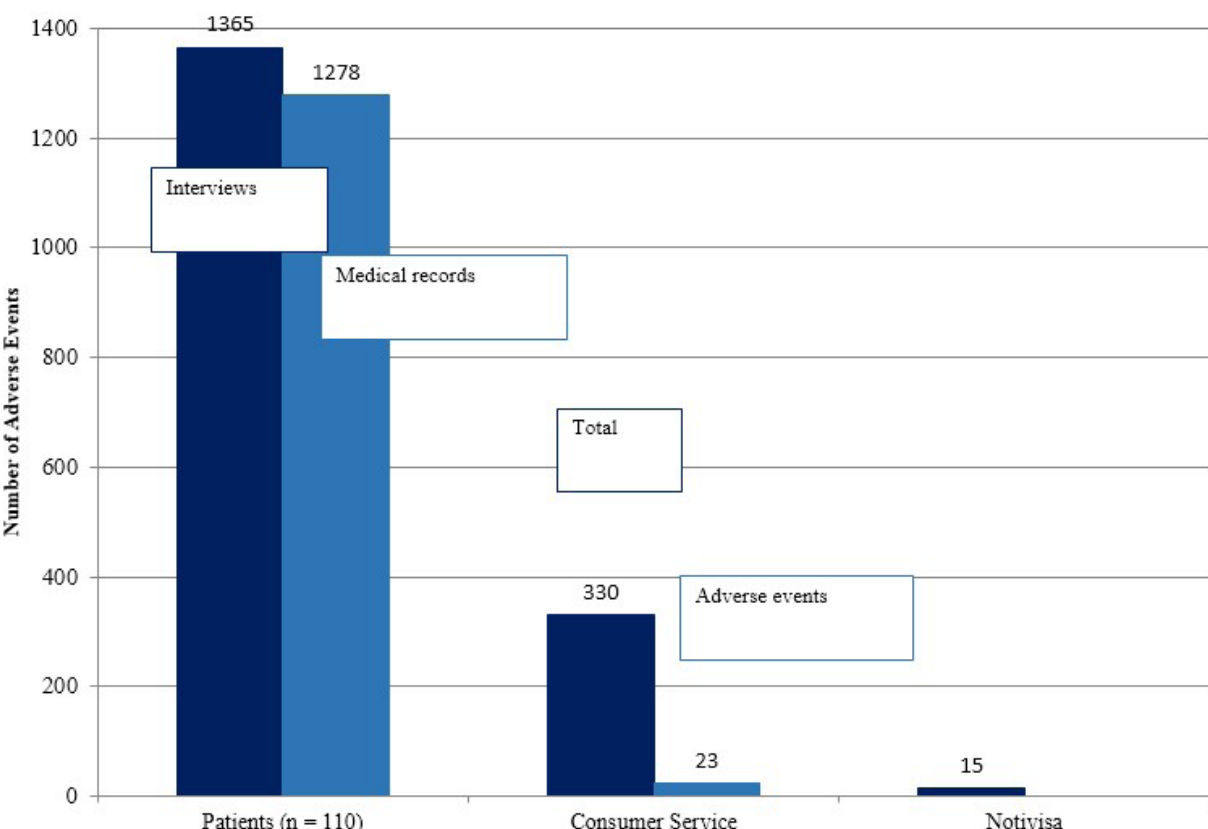
FIGURE 1 - Adverse events associated to thalidomide according to data